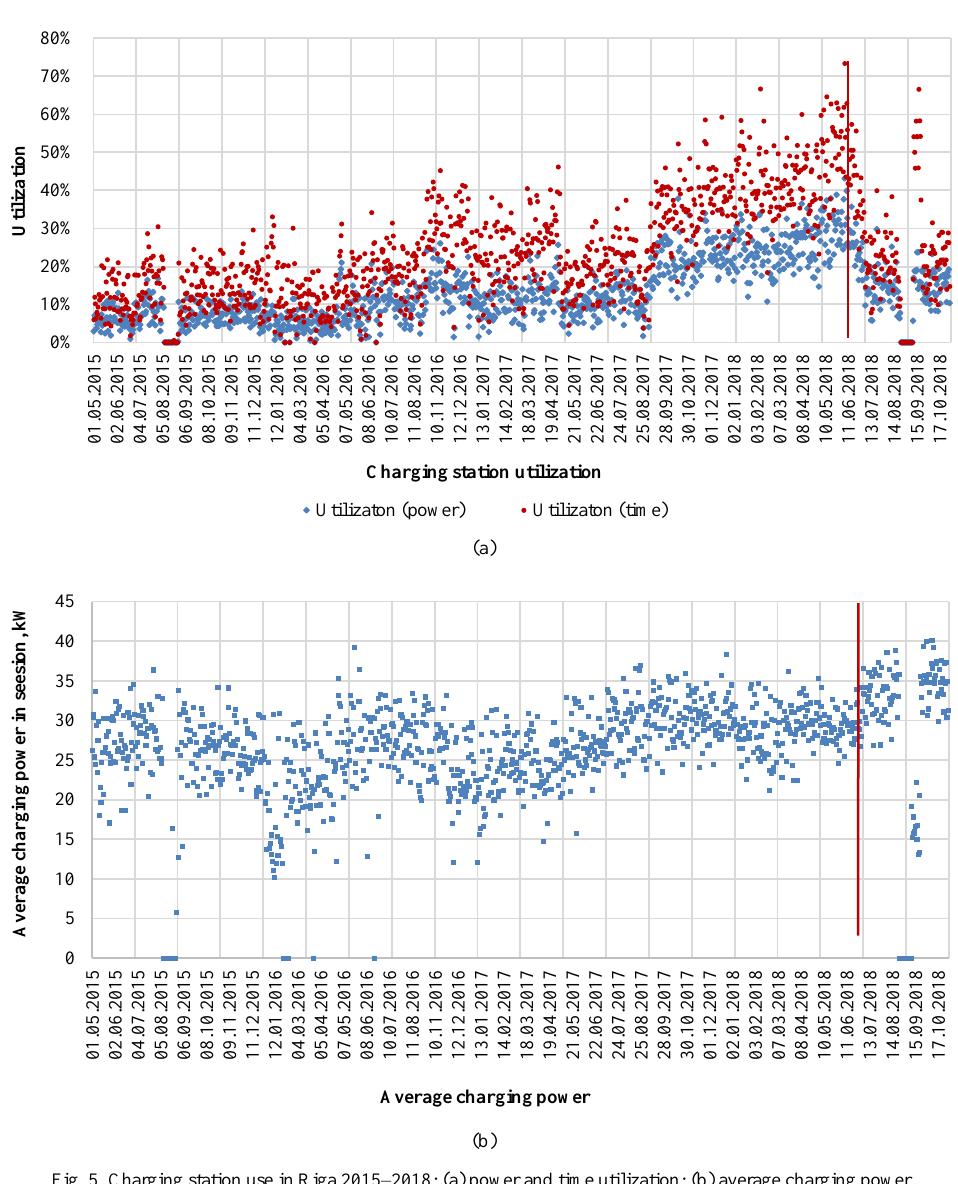
Fig. 5. Charging station use in Riga 2015–2018: (a) power and time utilization; (b) average charging power. As seen in Fig. 7, the charging station utilization was growing steadily from 2015 up to June 2018. Then there was a sharp drop in charging station use when the payments for charging were introduced in July 2018. However, after that there is also a gradual increase in charger